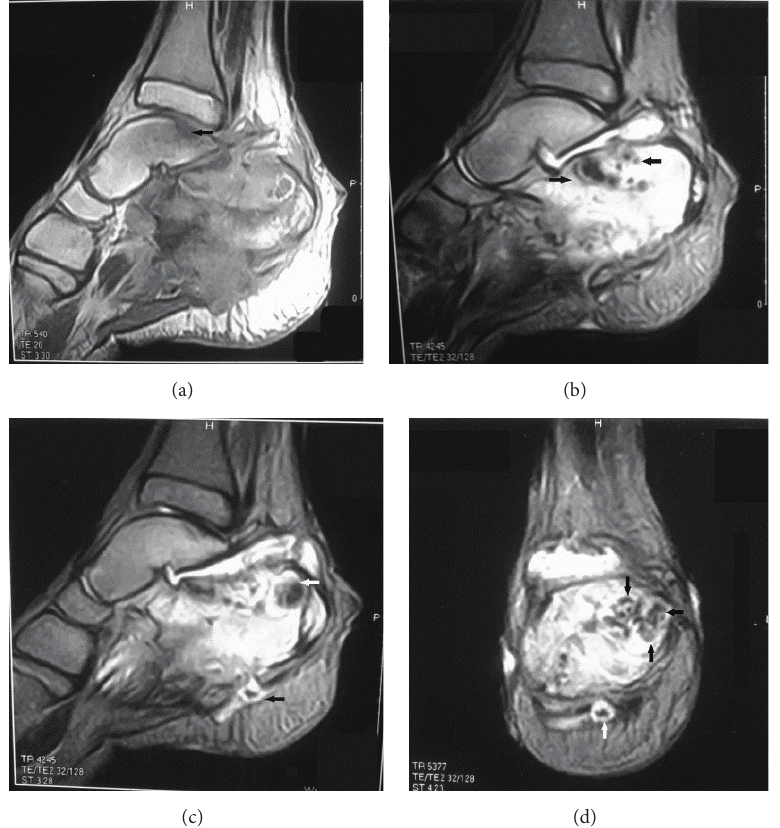
Figure1:(a)T1-weightedsagittalMRIoftherightfoot.Notethealteredmarrowsignalsseenalmosttotallyreplacingthemarrowtextureofthe calcaneus and to a lesser extent the opposing posteromedial aspect of the talus (black arrow) eliciting an abnormal low signal. (b) T2-weighted sagittal MRI of the right foot. Note the abnormal high signals replacing the marrow texture of the calcaneus. Note the multiple low-intensity lesions (black arrows) that may represent a conglomerate of grains in the background of diffuse high-intensity inflammatory bone changes. These low-intensity lesions are known as dot in circle. (c) T2-weighted sagittal MRI of the right foot. Note the low-intensity cavitary lesion of the posterior calcaneus (white arrow) that was found to correlate well to a conglomerate of black grains noticed in the gross pathologic specimen of the calcaneus. Note the same low-intensity lesion (black arrow) in the background of diffuse hyperintense inflammatory soft tissue changes (dot in circle). (d) T2-weighted coronal MRI of the right foot. Note the multiple small low-intensity lesions (black arrows) that may represent a conglomerate of grains in the background of diffuse hyperintense inflammatory bone changes. The same lesion is depicted in the soft tissue (white